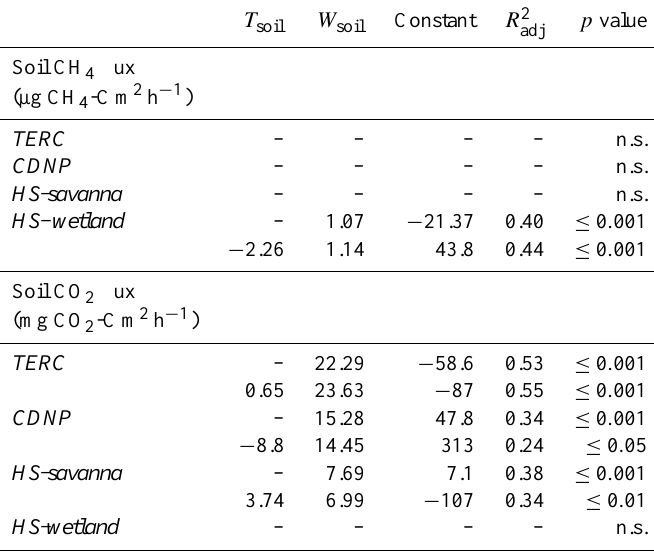
Table 4. Significant linear regression models of soil CH 4 and CO 2 fluxes with soil temperature ( T soil in ◦ C) and soil water content ( W soil in %) as determined by single factor and multiple linear regression procedure for individual study